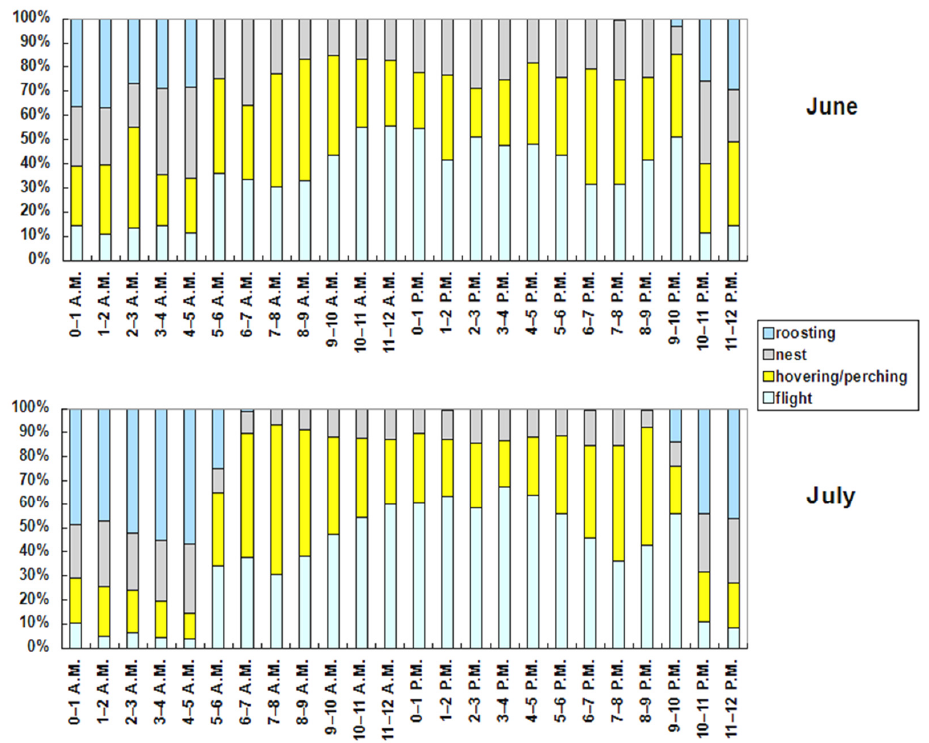
Figure 8. Hourly ethogram (local time) of the tracked red-footed falcons split on a monthly basis.